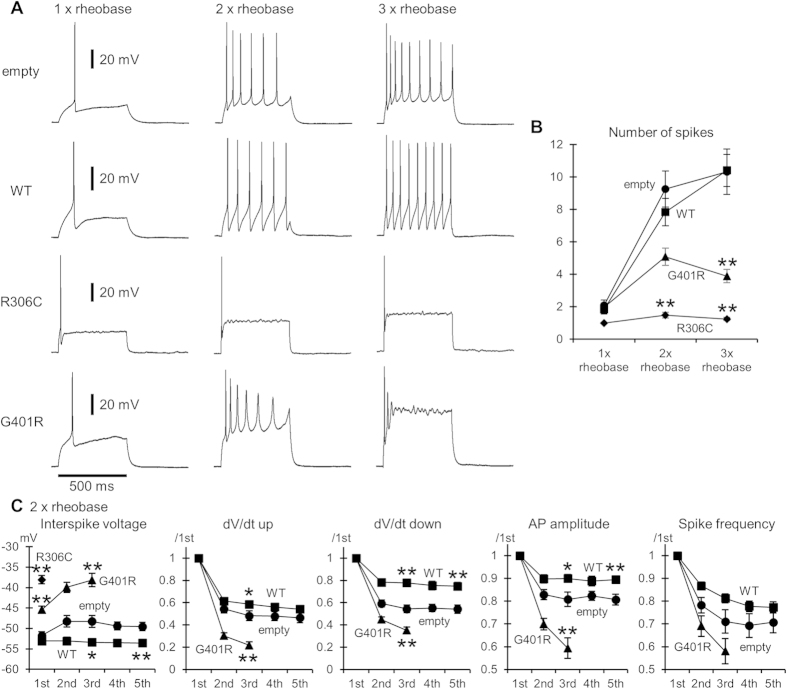
Repetitive firing properties of Kv2.1 mutant-transfected primary cortical neurons.(A) Representative traces of repetitive AP firing evoked by 500 ms current injections of one, two, or three times the rheobase amplitude. (B) Changes in the number of AP spikes generated during a 500 ms current injection with increasing current amplitude. **P < 0.01 compared with others by Kruskal-Wallis test. (C) Changes in the minimum interspike voltage level, maximum speed of spike upstrokes (dV/dt up) and downstrokes (dV/dt down), spike amplitude (AP amplitude), and instantaneous spike frequency (reciprocal of the interspike interval) during repetitive firing evoked by a 500 ms current injection of two times the rheobase. Parameters values of the initial five spikes and intervals in empty and WT, up to the third spike in G401R, and only the first interspike voltage in R306C were compared, because of differences in average spike number during injections, as shown in (B). Values of dV/dt up, dV/dt down, AP amplitude, and spike frequency were normalized to the first spike and frequency. *P < 0.05, **P < 0.01 compared with empty by Dunnett’s T3 test. The first interspike voltages in R306C and in G401R also differed significantly (P < 0.01). The numbers of cells analyzed in (B,C) are indicated in the bars in Fig. 5A.